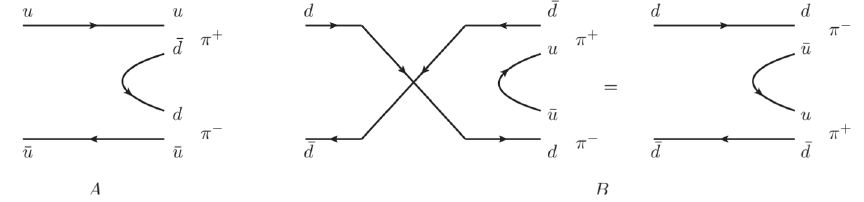
Figure 6 . Strong vertexes of ρ 0 → π + π − and ω → π + π −